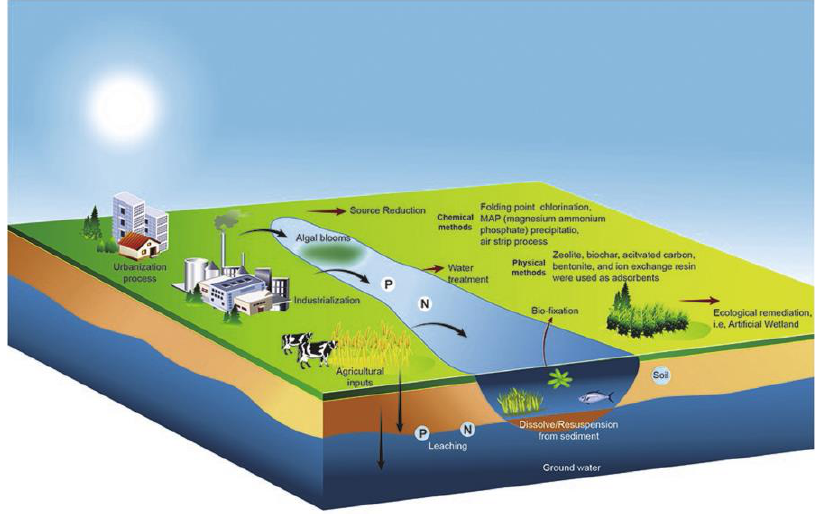
Figure 6. Source and control of nutrients (N and P) in the water environment [112]. Copyright 2020, Elsevier.